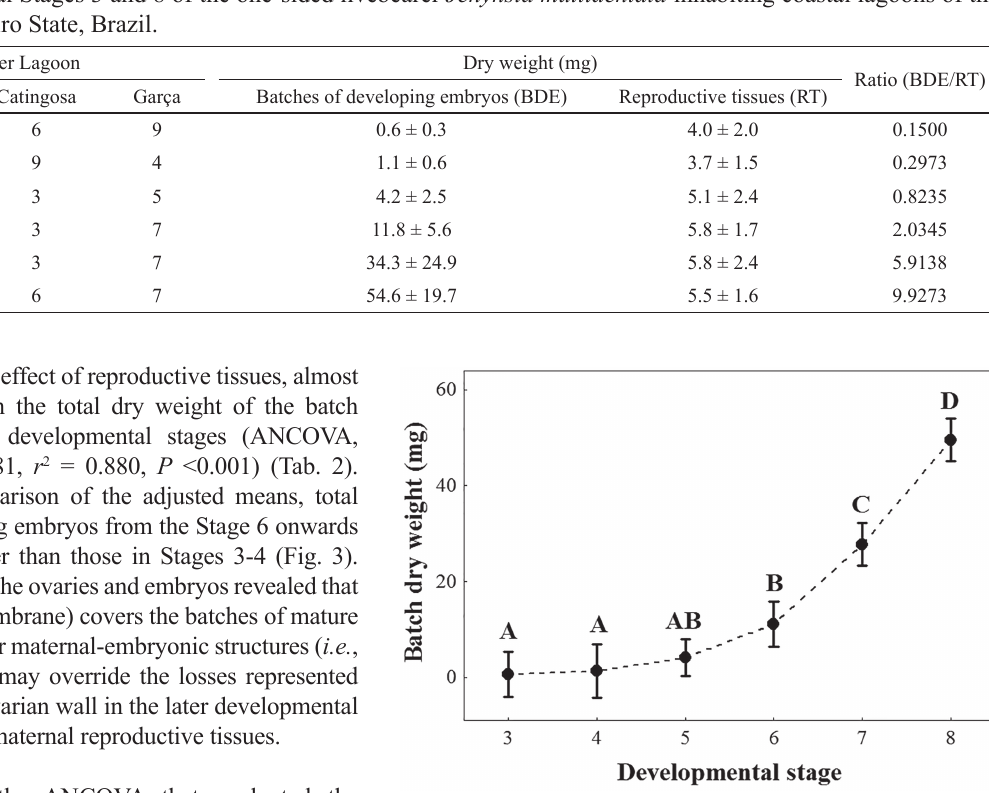
Fig. 3. Variation in dry weight of batches of developing embryos (adjusted mean ± 95% confidence interval) of the one-sided livebearer Jenynsia multidentata through the progressive stage of development, after controlling the effect of the dry weight of reproductive tissues. The values of the x-axis range from the beginning of eye pigmentation (Stage 3) to the mature embryo (Stage 8), according to the stages proposed by this study. Different letters (A-D) identify averages that differed significantly between stages of development according to Tukey’s test.